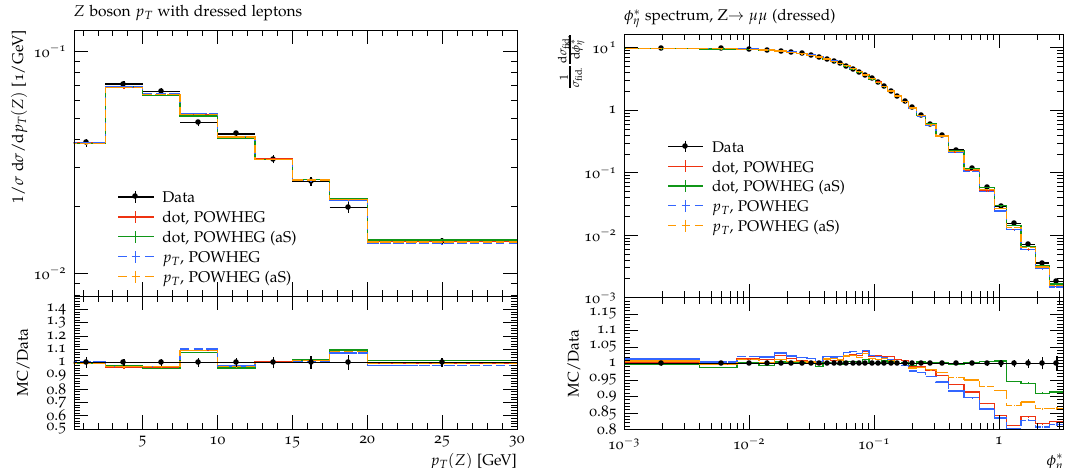
Figure 4 . Normalised differential cross section of Z → µ + µ − as a function of Z p ⊥ (left panel) and of the φ ∗ parameter (right panel). Herwig results, obtained using the POWHEG matching η prescription, are compared to CMS [17] and ATLAS [15] data at 7